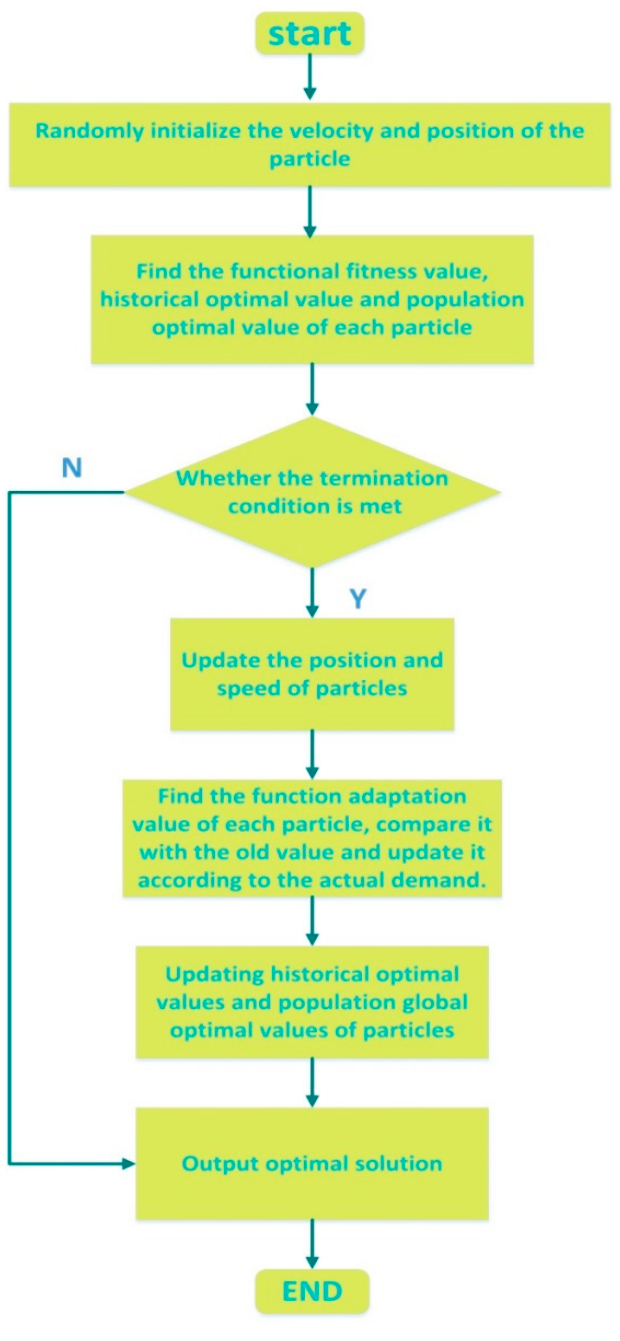
Figure 1. Flow chart of particle swarm optimization (PSO) algorithm.